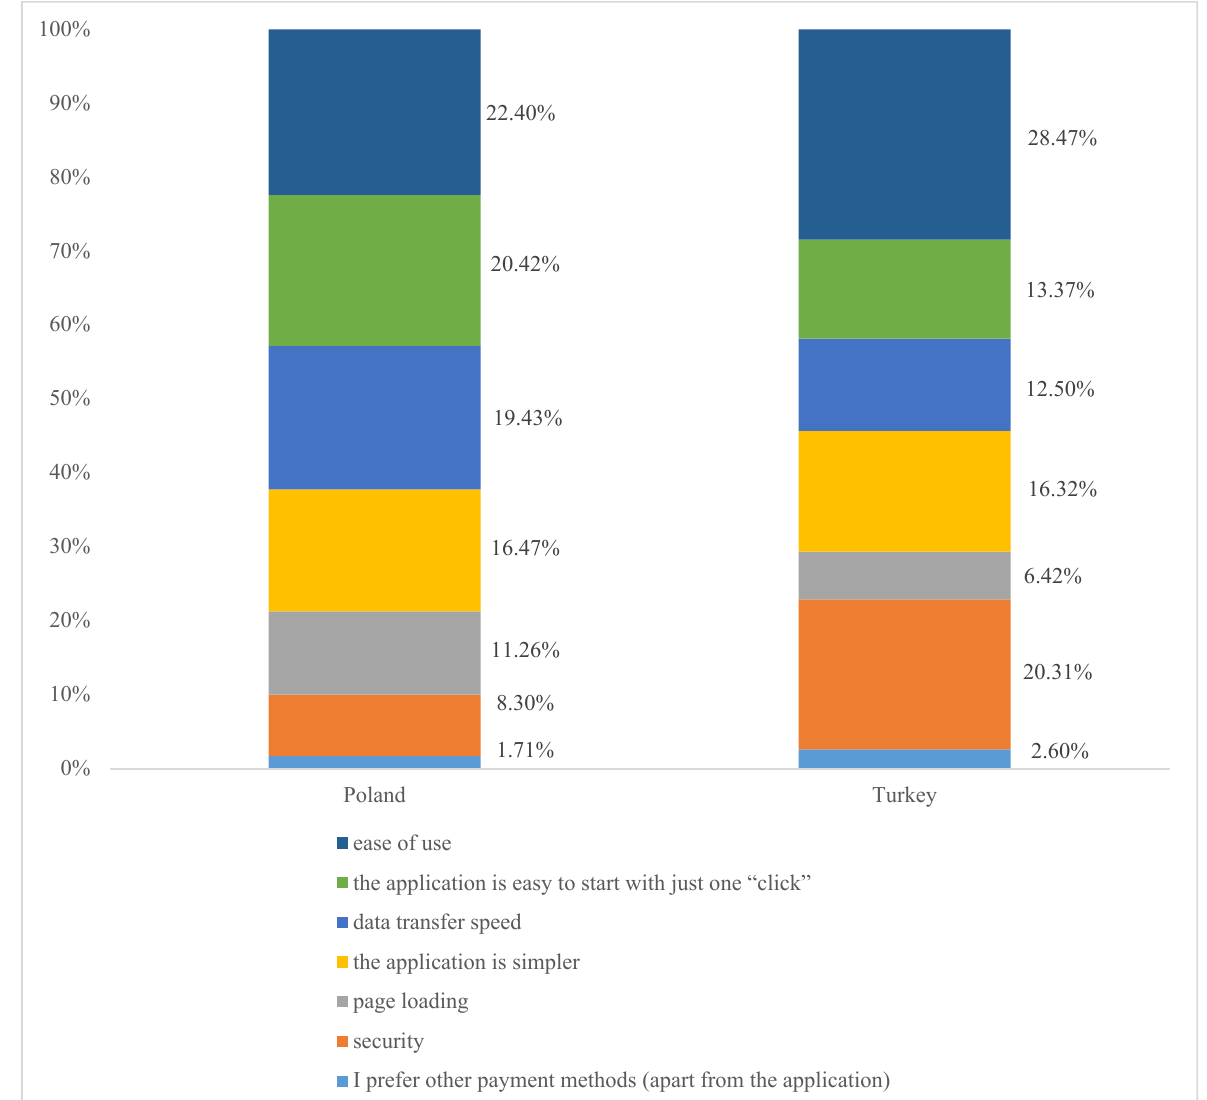
Figure 2. The advantages of choosing an m-banking application as a mobile payment tool; source: own work.